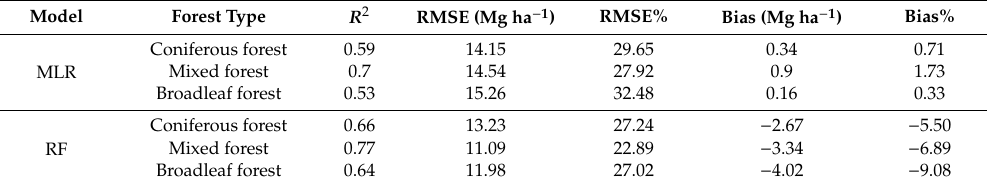
Table 6. Estimation accuracy of di ff erent models.